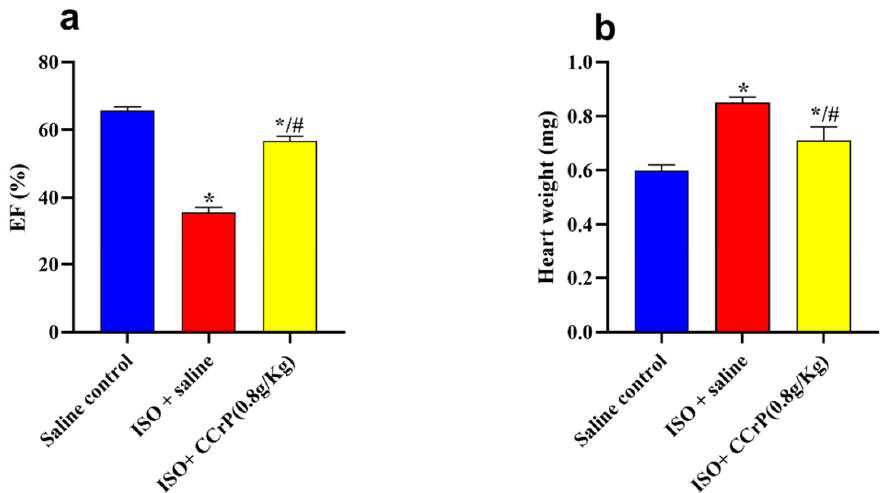
Figure 3. CCrP prophylactically administered before the first ISO injection continued to prevent myocardial injury and the development of cardiac dysfunction (EF%) ( a ) and HWI ( b ) at the end of 14-day treatment. Data are presented as mean ± S.E.M. of 4–6 rats. *: statistical significance ( p < 0.05) compared to the saline/control group. #: statistical significance ( p < 0.05) compared to the ISO + saline group. ISO: isoproterenol; CCrP: cyclocreatine phosphate; and EF: ejection fraction. HWI—ISO/saline rats showed a significant increase in HWI (0.85 ± 0.02 mg) compared